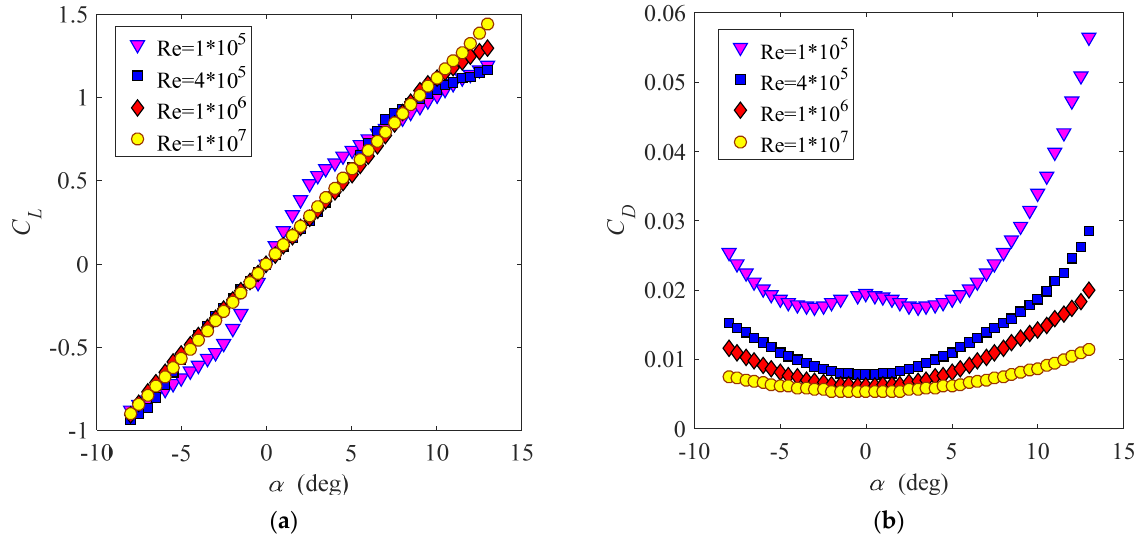
Figure 5. Variations of ( a ) C L and ( b ) C D with α of NACA0015 at different Reynolds numbers.